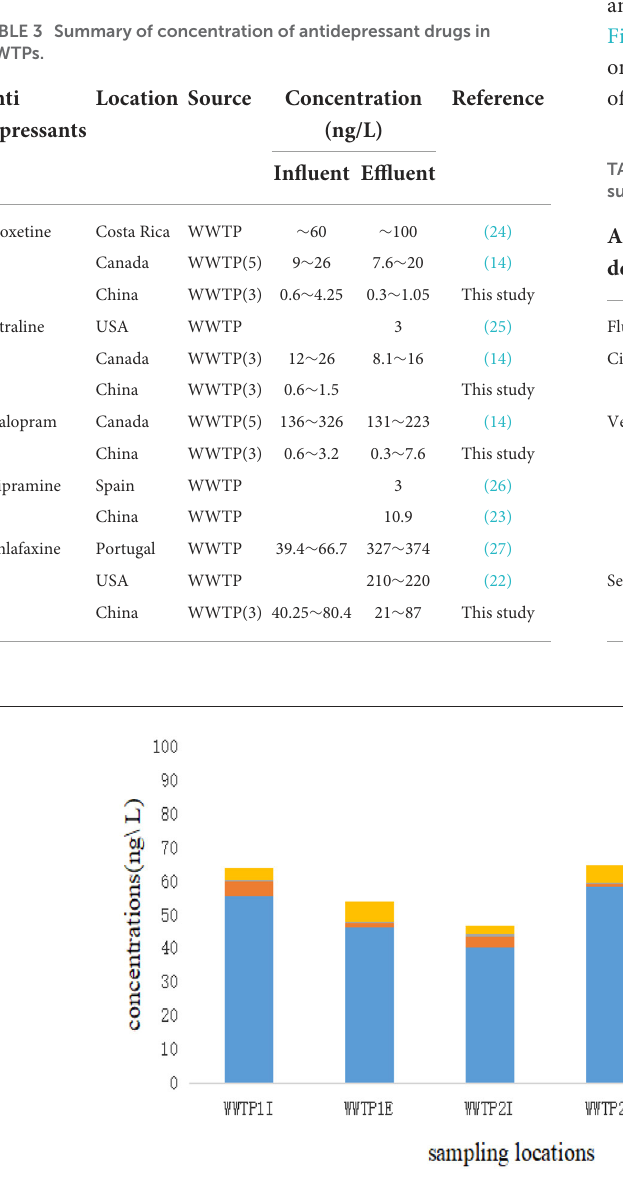
FIGURE2 Concentration of antidepressant drugs in